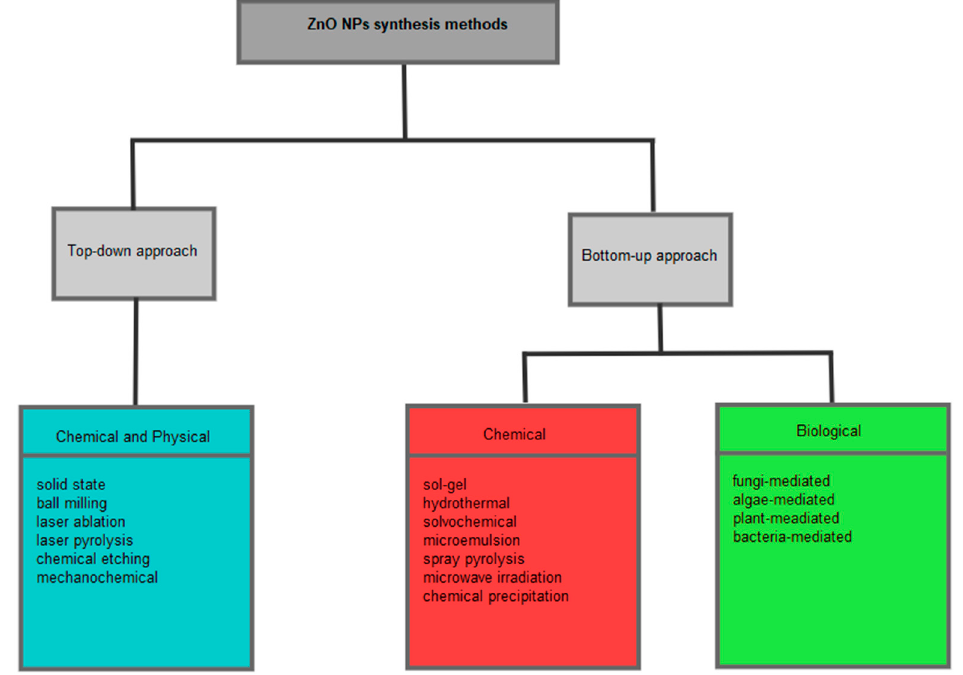
Figure 2. Overview of some of the methods used for ZnO NPs preparation.